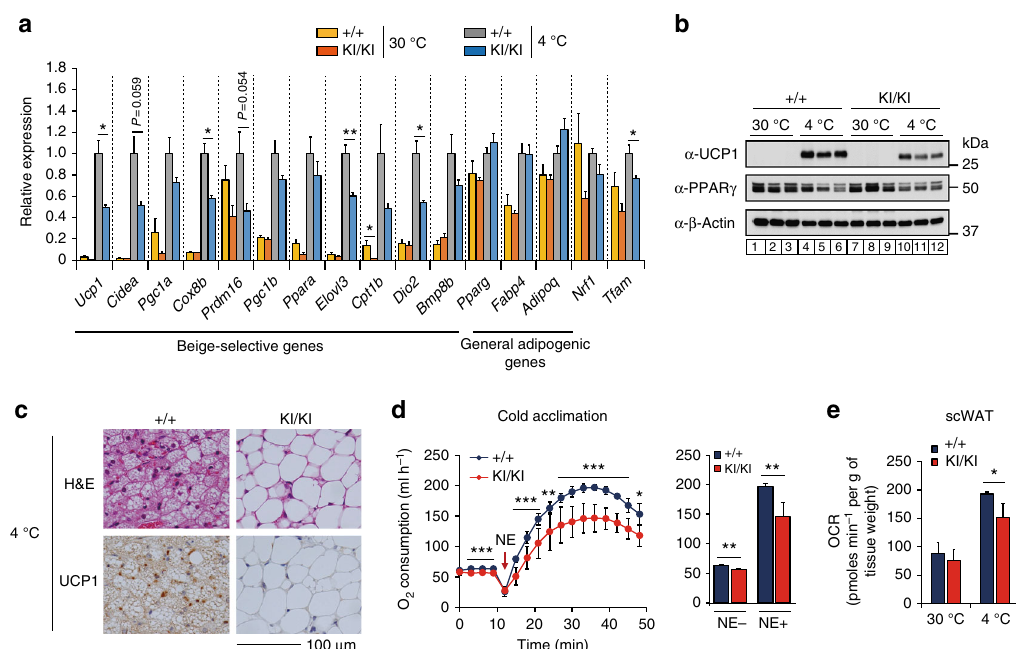
Fig. 2 Phospho-S265 JMJD1A induces beige biogenesis. a qPCR analysis demonstrates decreased expression of beige-selective genes in scWAT from Jmjd1a -S265A KI/KI mice exposed to 30 °C or 4 °C for 1 week ( n = 5 per genotype group). b Immunoblot analysis of UCP1 and PPAR γ in tissue homogenates of scWAT from mice presented in a . Uncropped images of the blots are shown in Supplementary Fig. 8. c Haematoxylin and eosin (H&E) and UCP1 staining sections of scWAT from WT and Jmjd1a -S265A KI/KI mice exposed to chronic cold exposure (4 °C for 1 week) (scale bar, 100 μ m). d NE-induced oxygen consumption rate (OCR) in mice exposed to chronic cold exposure (4 °C for 4 weeks) ( n = 7 per genotype group) (left). OCR before and 30 min after NE treatment are analyzed (right) ( n = 7). e OCR of scWAT from mice exposed to 30 °C or 4 °C for 1 week ( WT : n = 3; Jmjd1a -S265A KI/KI : n = 4). Data are mean ± s.e.m. a , d , e Analysis of variance were performed followed by Tukey ’ s post hoc comparison in a . Student ’ s t test was performed for comparisons in d , e . * P < 0.05, ** P < 0.01, and *** P < 0.005 were considered statistically signi fi